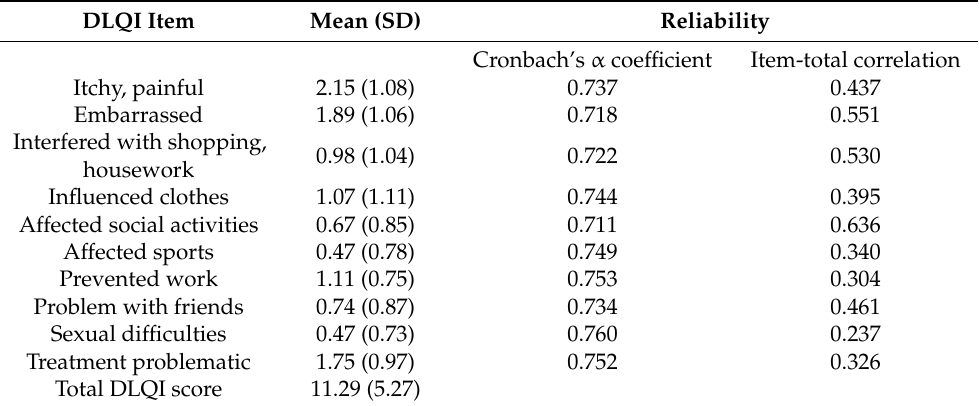
Table 2. Summary descriptive statistics and internal consistency reliability of the DLQI items. DLQI Item Mean (SD)